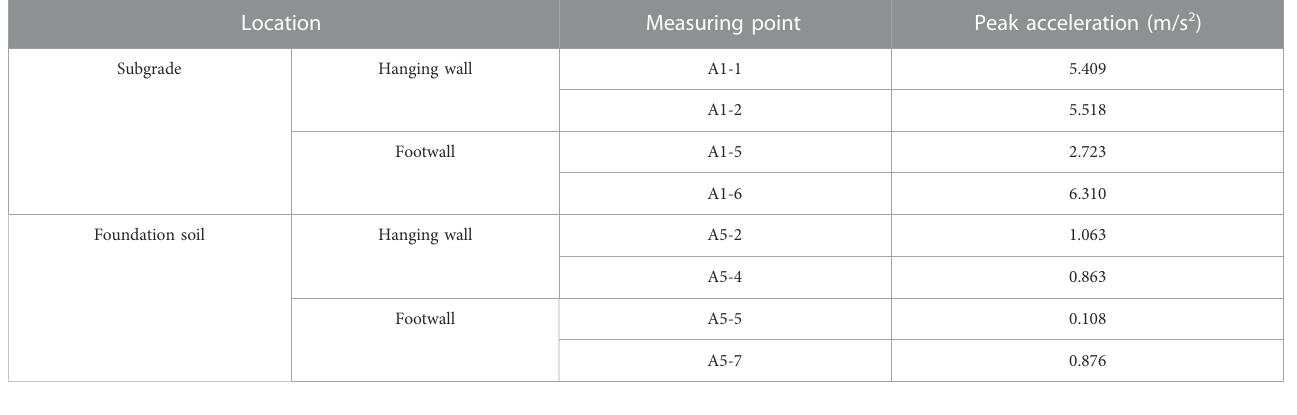
TABLE 5 Peak acceleration of measuring point in subgrade and foundation